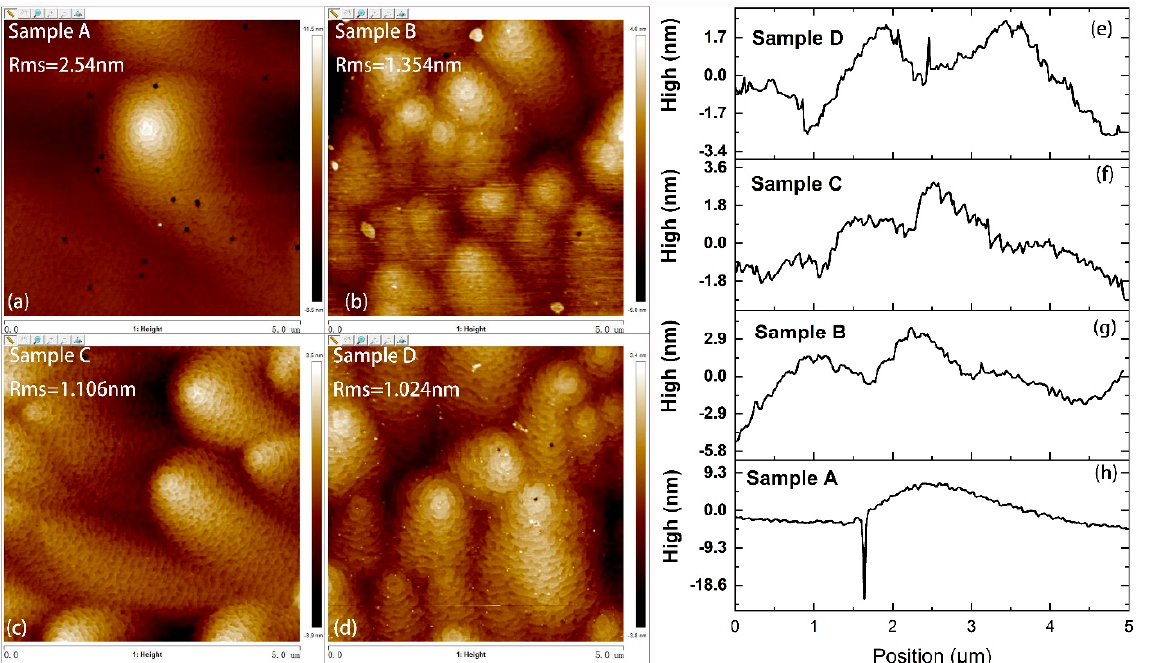
Figure 2. ( a – d ) AFM images of p-InGaN samples with scan area of 5 × 5 µm 2 ; ( e – h ) line scans of AFM images (color online).